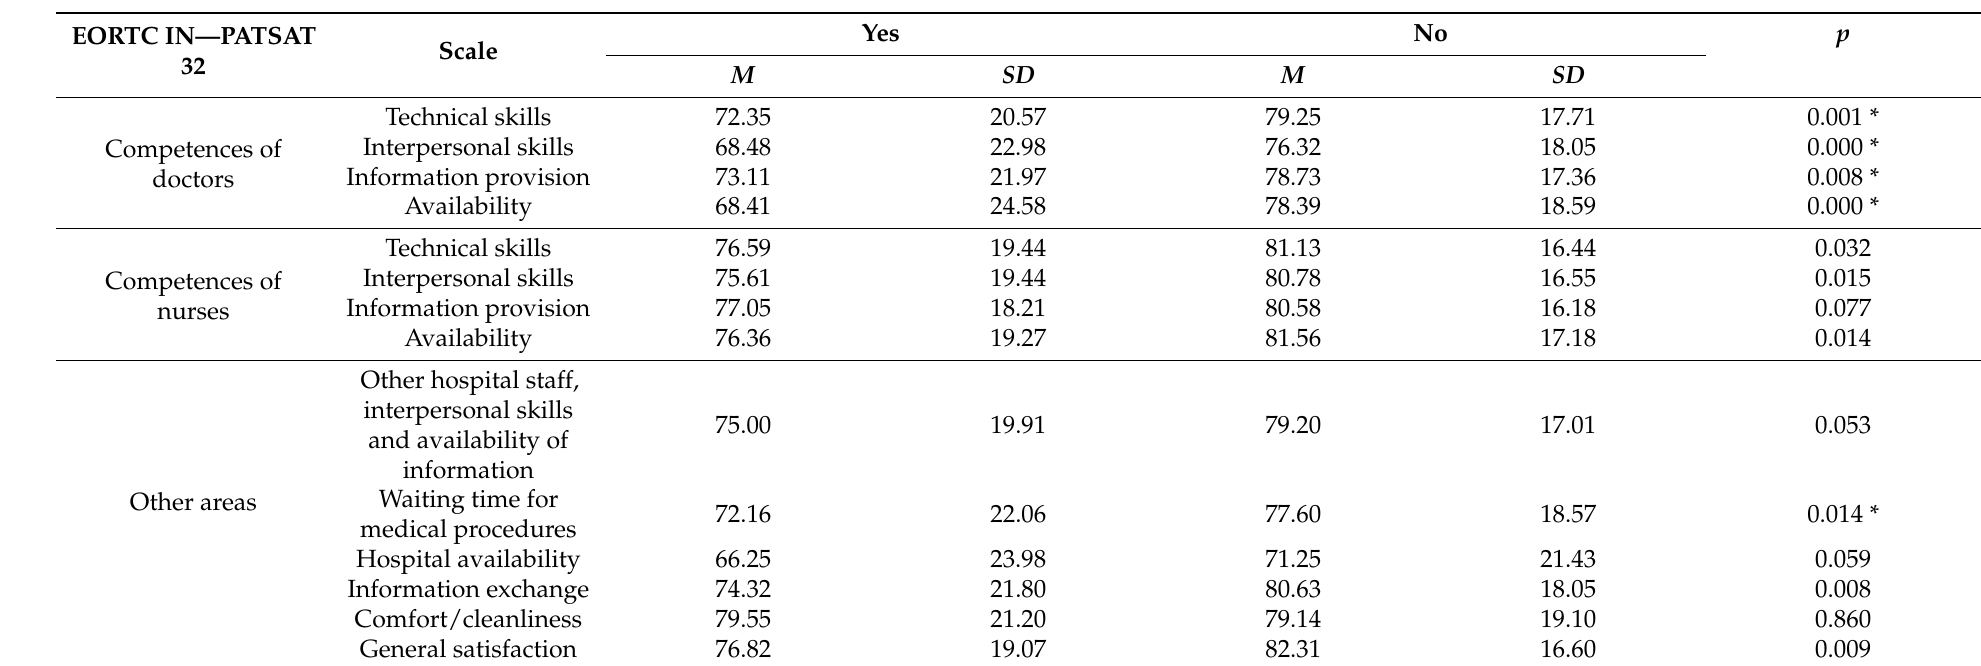
Table 6. Satisfaction with oncological care and delays in cancer